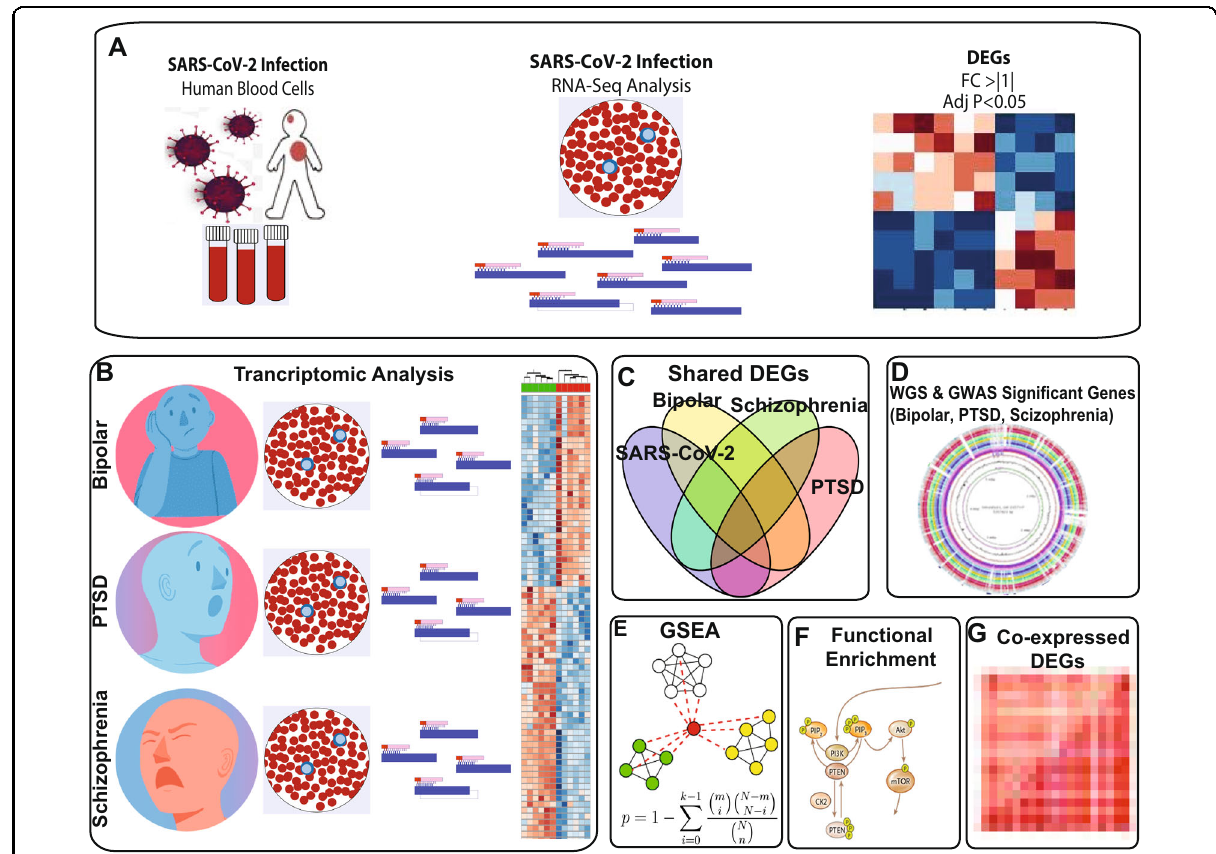
Fig. 1 Flow diagram of the study. RNA-Seq, GWAS and WGS analyses de fi ne genomic relationships and infection responses between the novel coronavirus SARS-CoV-2, and Bipolar, PTSD and Schizophrenia psychiatric disorders. A RNA-Seq gene expression pro fi ling of human peripheral blood mononuclear cells infected with SARS-CoV-2. B RNA-Seq gene expression pro fi ling of human peripheral blood mononuclear cells for the bipolar disorder, PTSD and schizophrenia. C Sparse overlapping gene expression signature between the SARS-CoV-2 and bipolar disorder, PTSD and schizophrenia. D WGS and GWAS data from the different curated data sources and fi ltered for the bipolar, PTSD and schizophrenia and identi fi ed concordant genes with the COVID-19 GWAS biomarker. E – G A similar conclusion was reached using the functional enrichment, pathways and co- expression analyses of the concordant